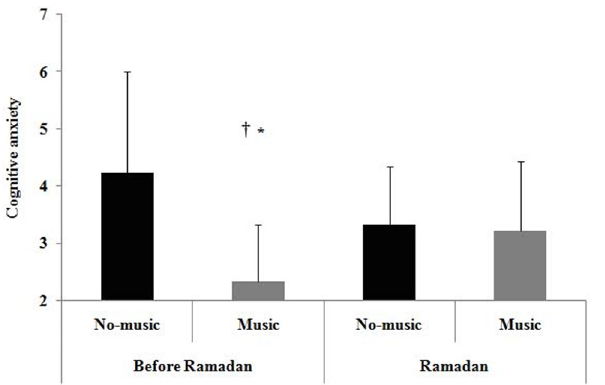
Fig 3. Means and standard deviations for cognitive anxiety according to Music and Ramadan period conditions. On the y-axis, the number 1 represents the label “ calm ” , whereas the number 11 represents the label “ worried ” . * : significantly different compared to no-music condition during the same period. † : significantly different compared to no-music condition of the other